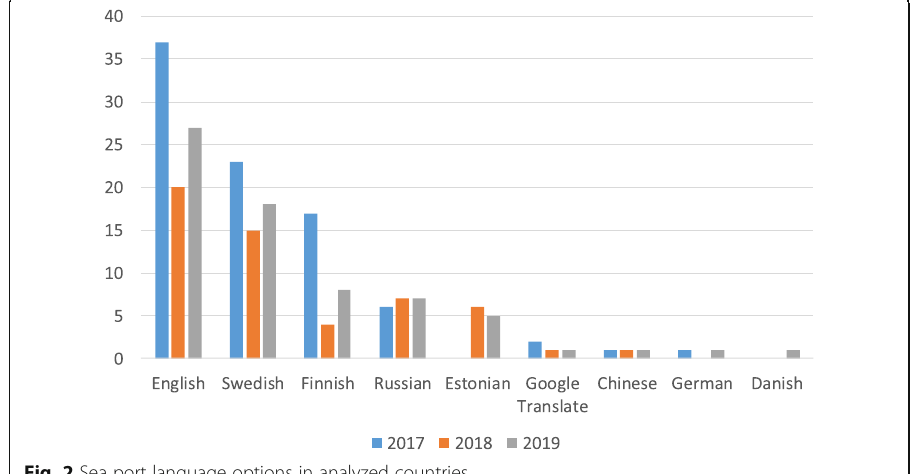
Fig. 2 Sea port language options in analyzed